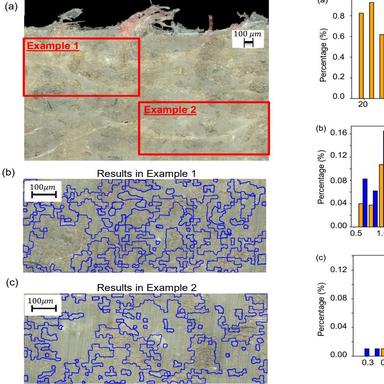
a)The microscopic image of the NFRC material, and the two selected examples (regions inside red rectangles); (b) contours (blue lines) of reinforcing elements in the Example 1 region; and (c) contours (blue lines) of reinforcing elements in the microscopic image in the Example 2 region.